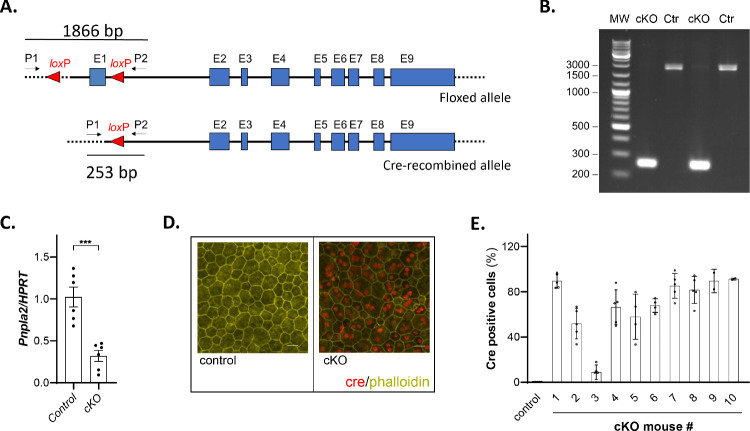
Generation of RPE-specific PNPLA2-cKO mice. (A) Scheme of Pnpla2 floxed and Cre-mediated recombined allele. The loxP sites flank exon 1. P1 and P2 are the primers homologous to sequences outside the floxed region (flanked by the loxP sites) used to detect Cre-mediated recombination (generating recombined alleles) on genomic DNA. The sizes of the amplicons obtained by PCR using P1 and P2 are indicated. (B) Gel electrophoresis of PCR reaction products obtained using primers P1 and P2 and genomic DNA isolated from mouse eyecups from either cKO or control (Ctr) mice (Pnpla2f/+); lane 1 (MW) corresponds to molecular weight markers (GeneRuler DNA Ladder Mix). One eyecup per lane from a 4-month-old mouse (n = 2 cKO, n = 2 Ctr). (C) Pnpla2 expression (vs. HPRT) in RPE from 1-month-old cKO mice (Pnpla2f/f/Cre) relative to control littermates (Pnpla2f/f). Each data point corresponds to the average of six PCR reactions per eyecup, six eyes from three cKO mice and six eyes from three control mice at 5 to 7 months old. (D) Cre (red) and phalloidin (yellow) labeling of RPE/choroid flatmounts from control (Pnpla2f/f) (left) and littermate cKO (Pnpla2f/f/Cre) (right) mice (n = 2 images from individual mouse eyecup at 11–14 months old). Scale
bar: 20 µm. (E) Plot of percentage of Cre-positive RPE cells in cKO animals (Pnpla2f/f/Cre;
n = 10; age, 10.5–18.5 months old) as indicated in the x-axis. Each data point corresponds to percentage of Cre-positive RPE cells from an ROI, each bar corresponds to a flatmount of an individual cKO mouse, and the bar for control (Pnpla2f/f) has data from 10 mice.